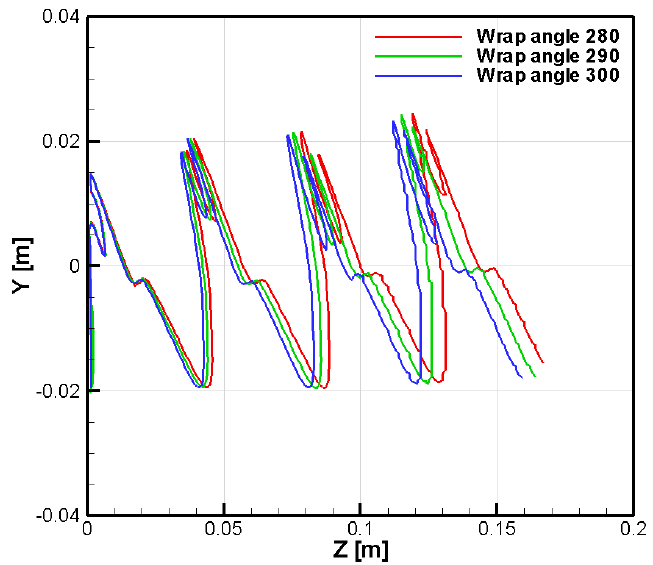
Figure 8. Comparison of sealing line length.